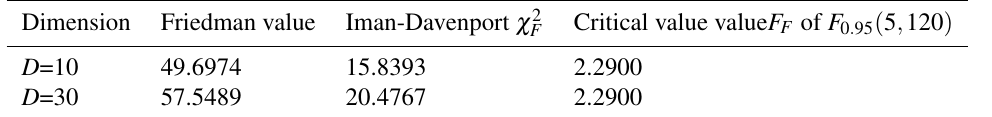
Table 5. Results of the Friedman and Iman-Davenport tests( α =0.05)